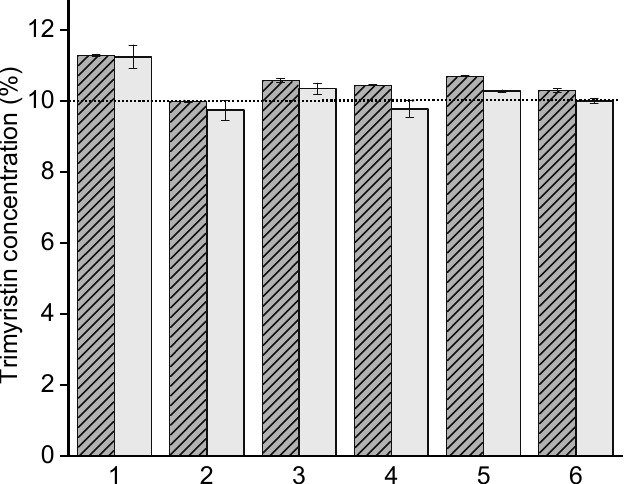
Figure 4. Comparison of trimyristin quantification of six different unloaded nanoemulsions via DSC (patterned bars; n = 3 ± standard deviation) and HPLC (uniform bars; n = 4 ± standard deviation). The dotted line represents the weighed-in amount.